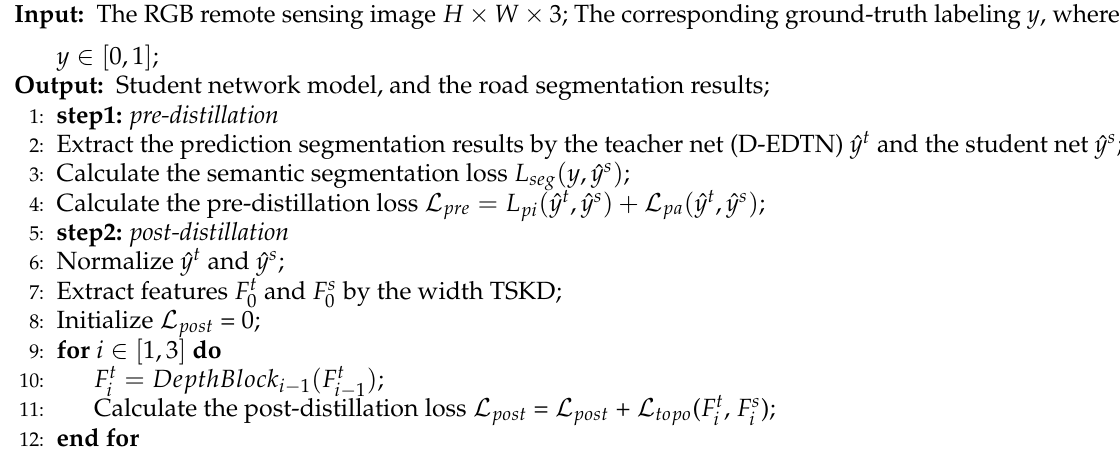
Algorithm 1 Topological space network for road extraction based on knowledge distillation